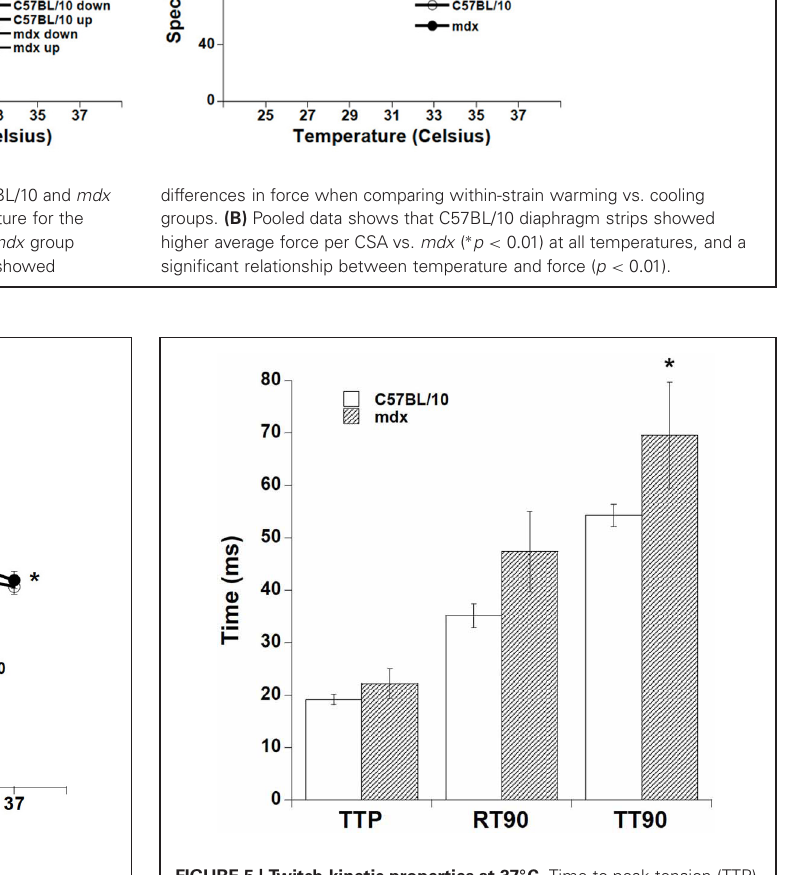
FIGURE 4 | Temperature dependency of C57BL/10 and mdx tetanic contraction kinetics. Time from first stimulation to 50% of maximal force is quicker with increasing temperature for tetanic contractions in all groups ( p < 0 . 01 for TT50).